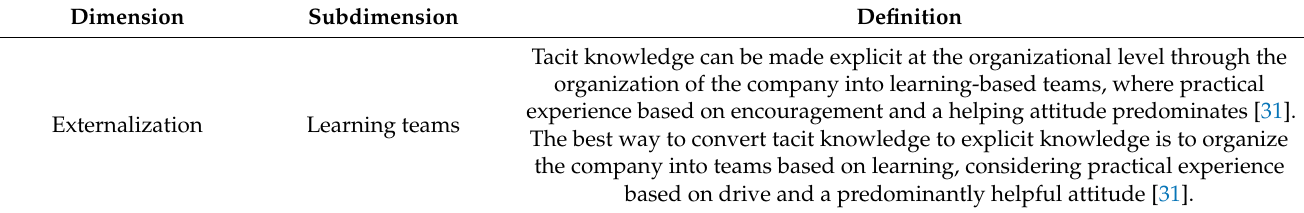
Table 2. The externalization dimension.